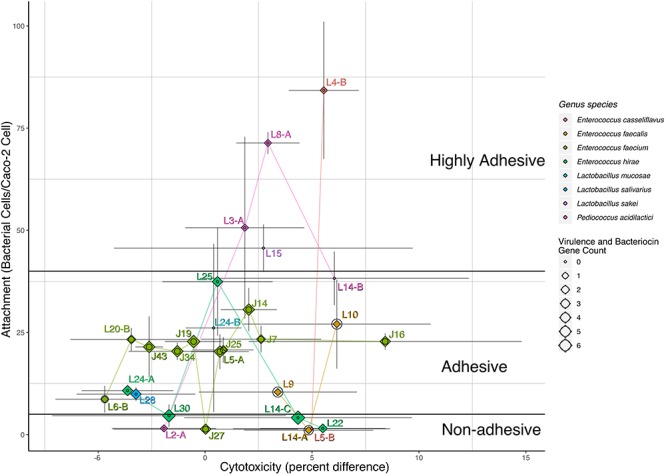
Attachment, cytotoxicity, virulence gene count, and bacteriocins. Labeled points of strain specific values for cytotoxicity and attachment are mapped to the x- and y-axis by bacterial cells/caco-2 cell and percent difference, respectively. Gray lines represent the confidence intervals for the mean estimate on either x- or y-axis. Points are colored and connected via lines of the same color based on each strain genus and species. Each labeled point is also represented by both a diamond and circle, the size of the diamond represents the number of bacteriocin genes, and the size of the circle represents the number of virulence-associated genes identified in the sequencing data. Black lines differentiate the adhesive potential as defined by Candela et al. (2005).